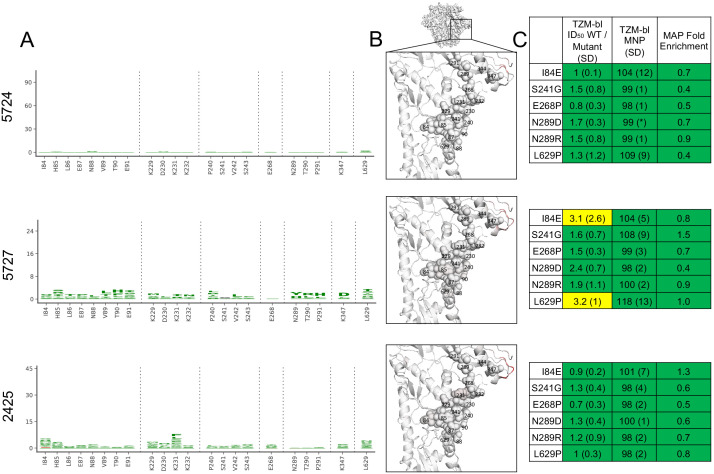
(A), (B), and (C) as in Figure 5, but for the three sera with limited targeting of the glycan hole epitope.